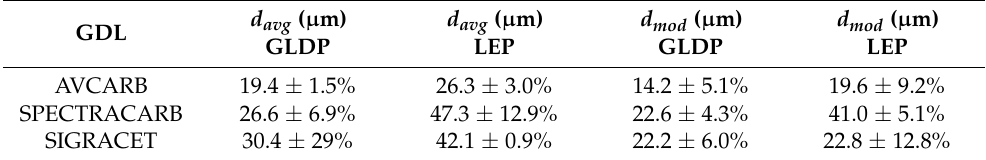
Figure 5. Experimental curves and resulting PSDs of SIGRACET GDL by ( a ) GLDP; ( b ) LEP. Table 2. Mean pore diameters ( d avg ) and most frequent diameter ( d mod ) obtained via GLDP and LEP for the three GDL samples